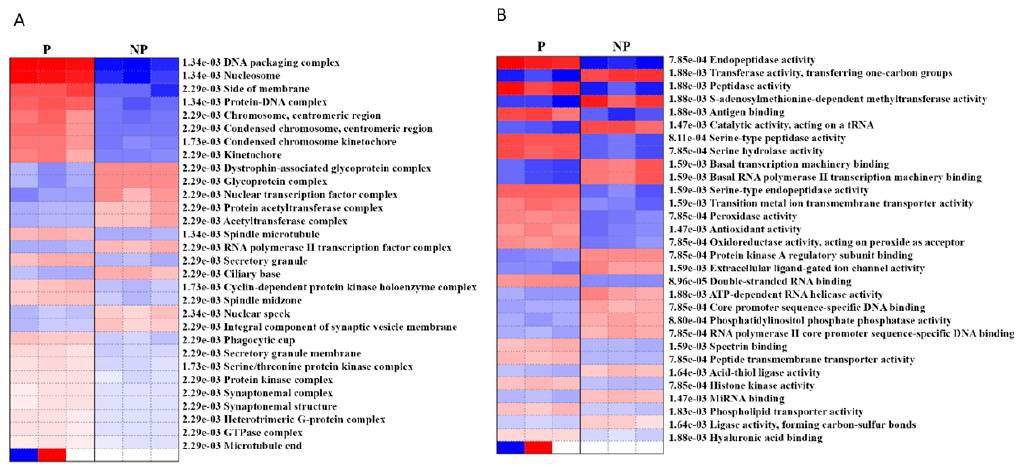
Figure 4. Pre-ranked gene set enrichment analysis (PGSEA) using gene ontology (GO) ( A ) cellular component and ( B ) molecular function. The corresponding activation (red)/suppression (blue) of components/functions are presented. The red and blue color gradients represent the level of activation/suppression, the higher level of activation is shown in dark red, and a higher level of suppression is shown in dark blue. NP-non-pregnant; P-pregnant.